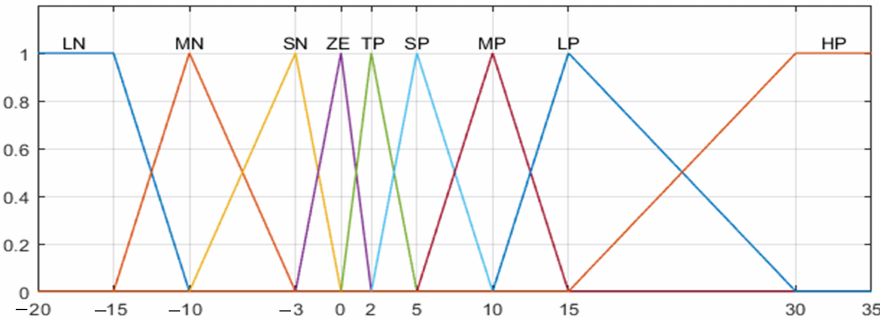
Figure 7. Membership functions of the change in duty cycle ∆ D .